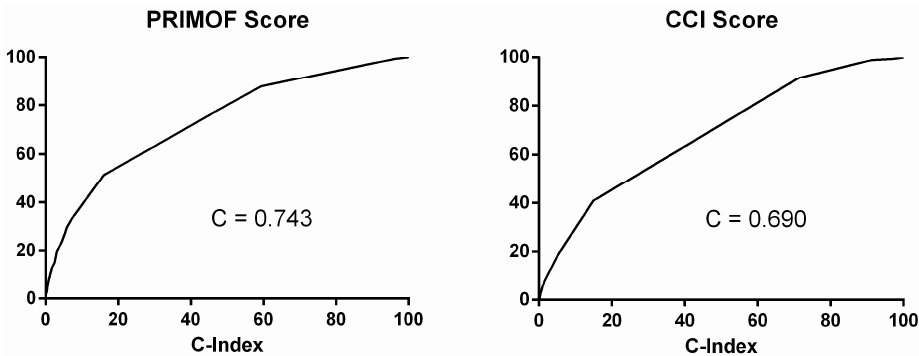
Figure 2. C-index of PRIMOF score and CCI score.